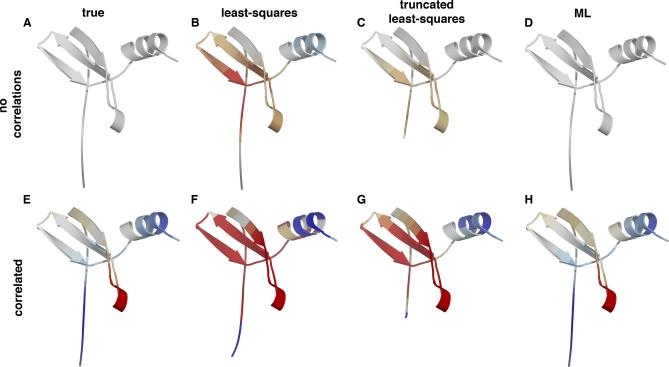
PCA Plots of Least-Squares and ML Superpositions of Simulated StructuresThe first principal component (PC) is plotted on the mean structure for various calculations. As in Figure 1, the upper row (A–D) uses a covariance matrix in which all correlations are zero (no correlation), whereas the lower row (E–H) uses a covariance matrix with strong correlations. Red regions are self-correlated, as are blue regions, while blue versus red regions are anti-correlated. White regions indicate no correlation.(A, E) The true first PC, extracted from the known correlation matrices.(B, F) The first PC based on the all-atom least-squares superposition.(C, G) The first PC from a least-squares superposition that excluded residues 1–5 with the largest variance in the simulation.(D, H) The first PC based on the ML superposition.